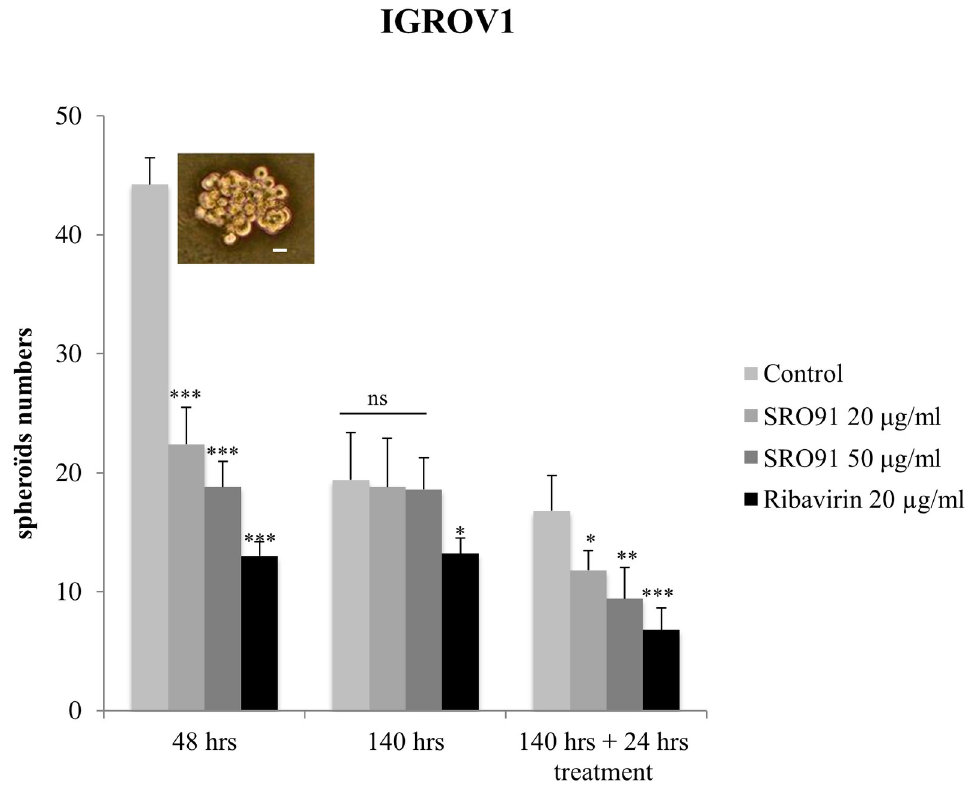
Fig 8. Cancer spheroids formation after SRO-91 or ribavirin treatment or without treatment (control). IGROV1 cancer spheroids formation was followed each day during 7 days. The number of spheroids was counted in at least ten fields in each condition. Inset: IGROV1 spheroid. Scale bar is 50 μ m. Results are representative of at least three independent experiments. P-values were calculated by Paired one-way ANOVA test ( � P < 0.05. �� P < 0.01, ��� P < 0.001. ns: no